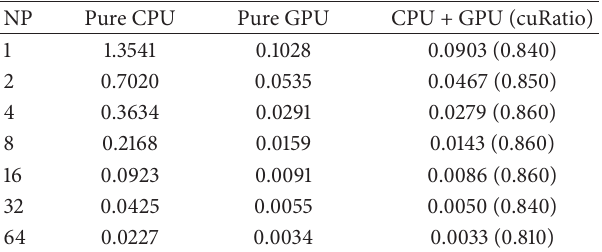
Table 3: Loop time information used in Figure